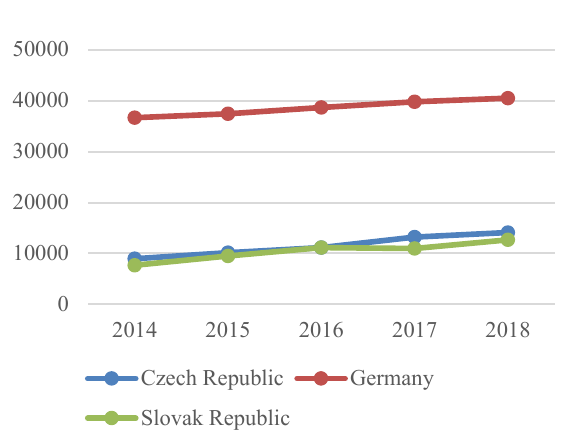
Figure 3. Average remuneration of a road freight transport employee in euros